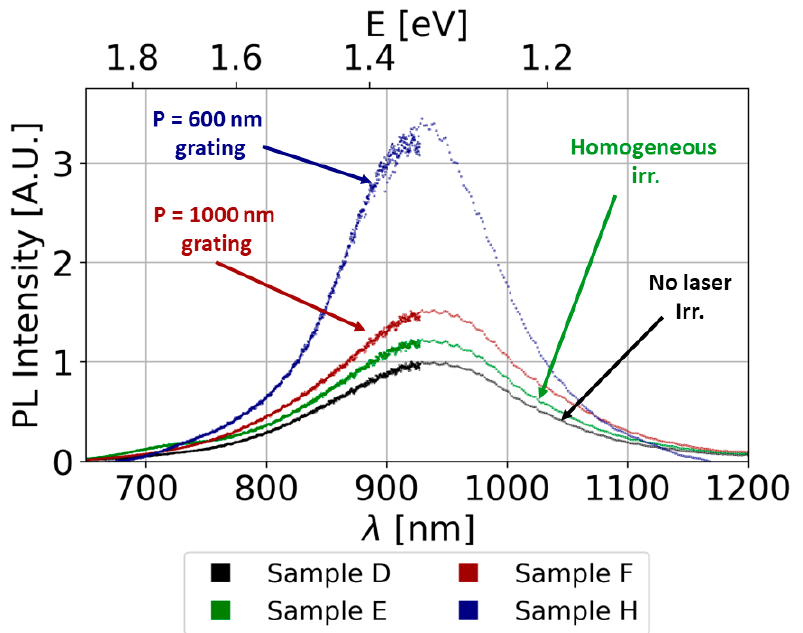
Figure 4. PL spectra of high-temperature annealed and hydrogen-passivated SiO x samples. Ho- mogeneous laser irradiation of the SiO x layer results in a slight increase in the PL signal. Periodic structuring of the SiO x layer results in a significantly stronger enhancement of the PL signal. The enhancement depends on the period of the structure. PL intensity scaling identical to Figure